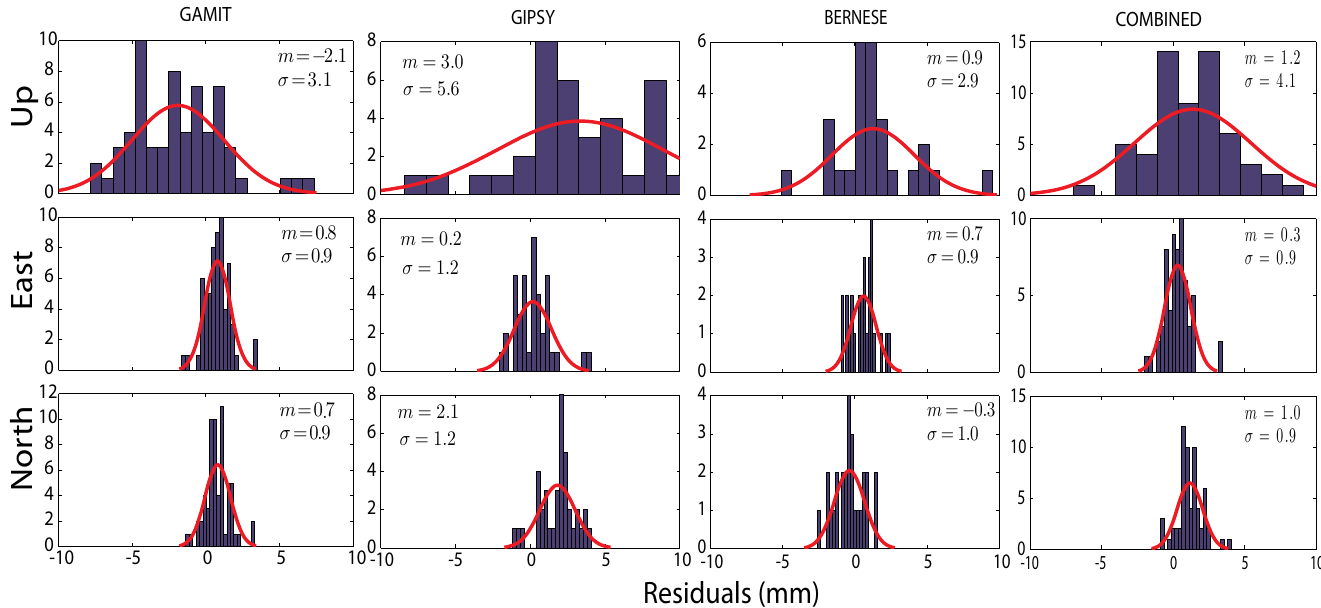
Figure 5. Distribution of the far-field offsets for the individual (BERNESE, GAMIT and GIPSY) and COMBINED May 20, 2012, solutions. Red line, best- fit Gaussian curve. The median (m) and dispersion ( ) are computed for the three spatial directions (up, east, north).